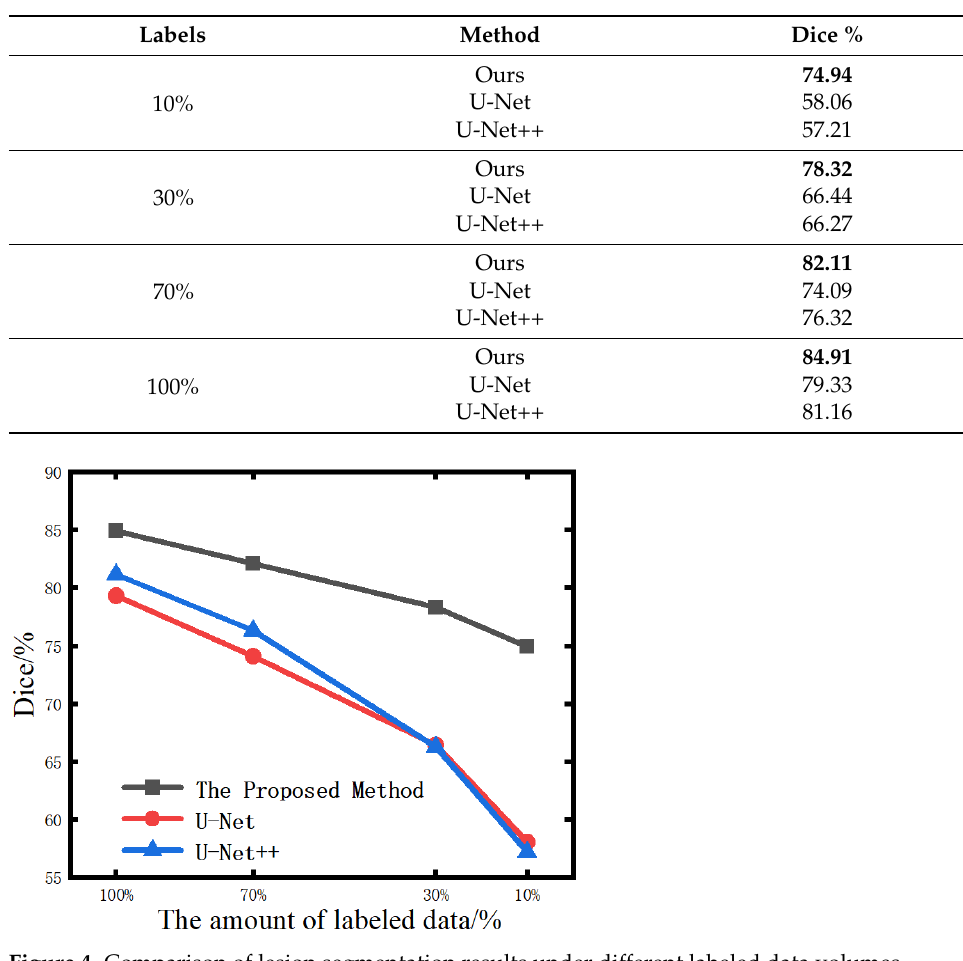
Table 4. Comparison of Dice coefficients of three segmentation methods under different labeled data volumes.